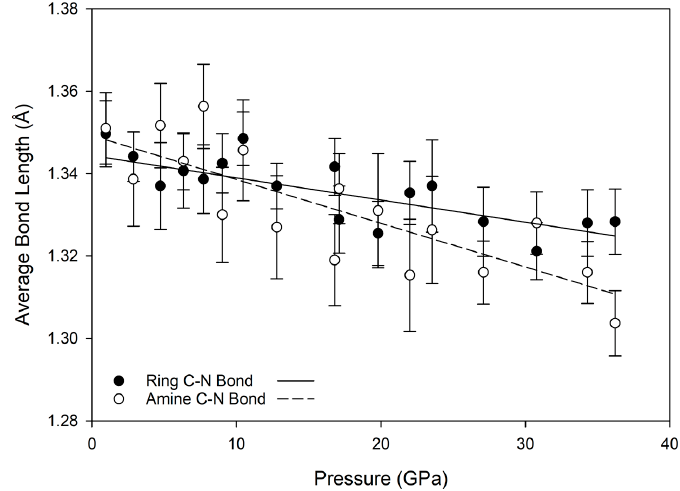
Figure 6. Average carbon-nitrogen bond lengths for ring and amine components of melamine. Each follows a loosely linear decrease in length with pressure.